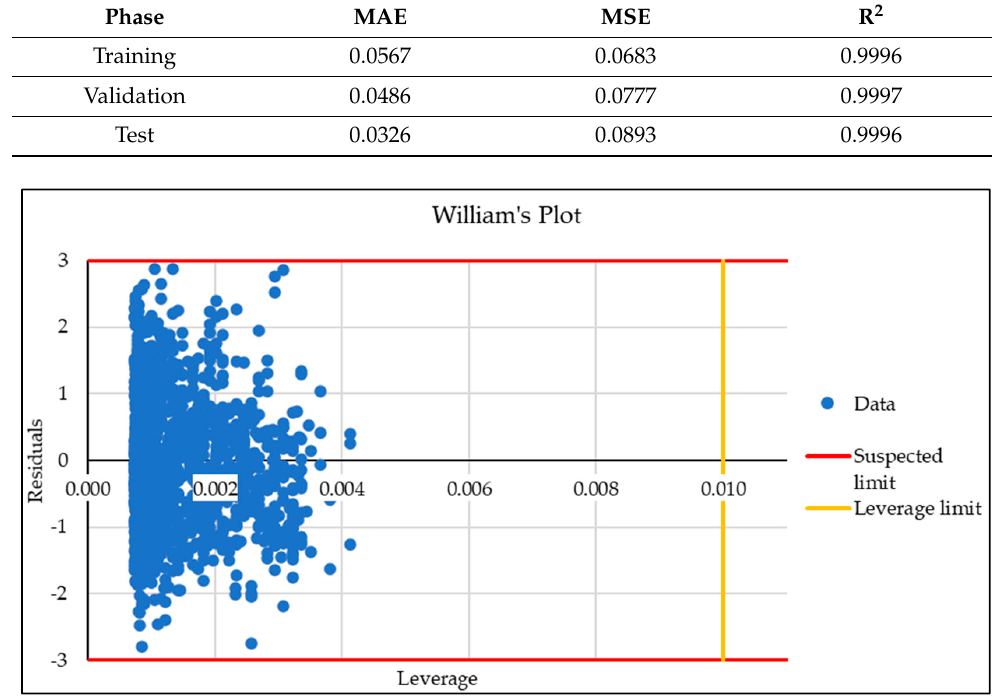
Figure 6. William’s plot of the ANN model.